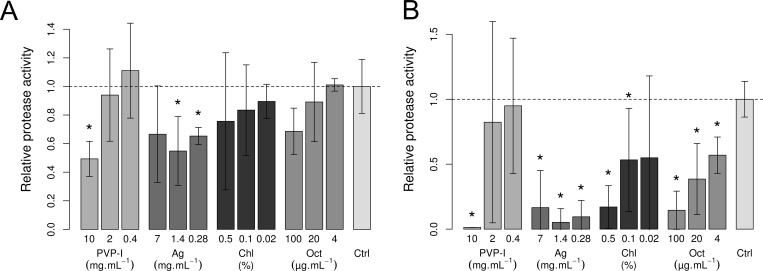
Activity of bacterial proteases with antimicrobials in SDS-PAGE zymography.(A) A mixture of bacterial proteases was separated on polyacrylamide gels with gelatin and incubated overnight in developing buffer that contained decreasing amounts of povidone-iodine (PVP-I), silver lactate (Ag), chlorhexidine digluconate (Chl), and octenidine hydrochloride (Oct). The values are expressed as relative protease activity related to control (Ctrl) with no added antimicrobial. (B) The activity of eukaryotic proteases similarly incubated with varying concentrations of antimicrobials. In panels A and B, bars represent standard deviation, * denotes p < 0.05 (Student's one sample t-test to control), n = 4.